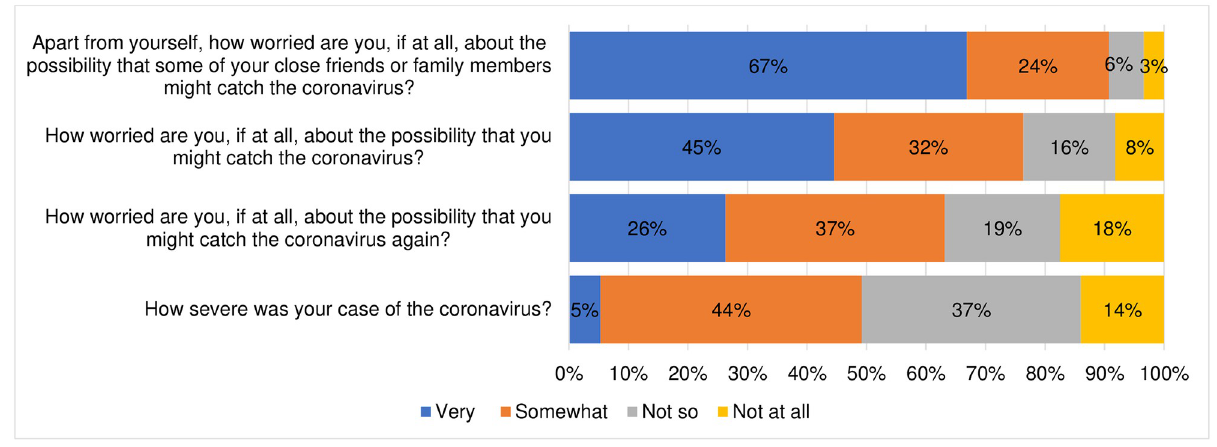
Fig 1. Risk of contracting COVID-19.